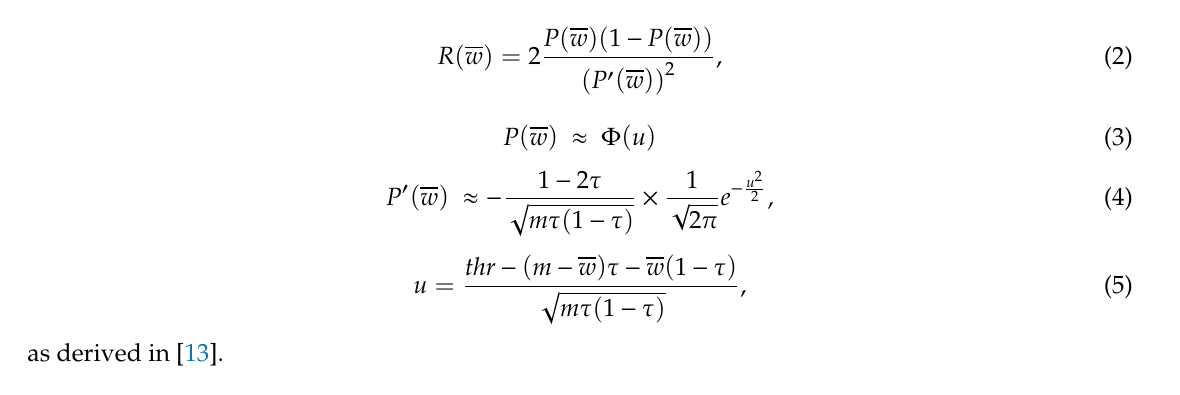
(cid:16) (cid:17) a , b , z obtained by eavesdropping a previous authentication (cid:16) (cid:12) (cid:12) (cid:48) ( w ) (cid:12) (cid:12) (cid:48) ( w ) (cid:12) (cid:12) (cid:12)(cid:17) (cid:12) (cid:12) ∈ P ( w ) − with high probability (cid:12) , P ( w ) + (cid:12) rP (cid:12) rP n